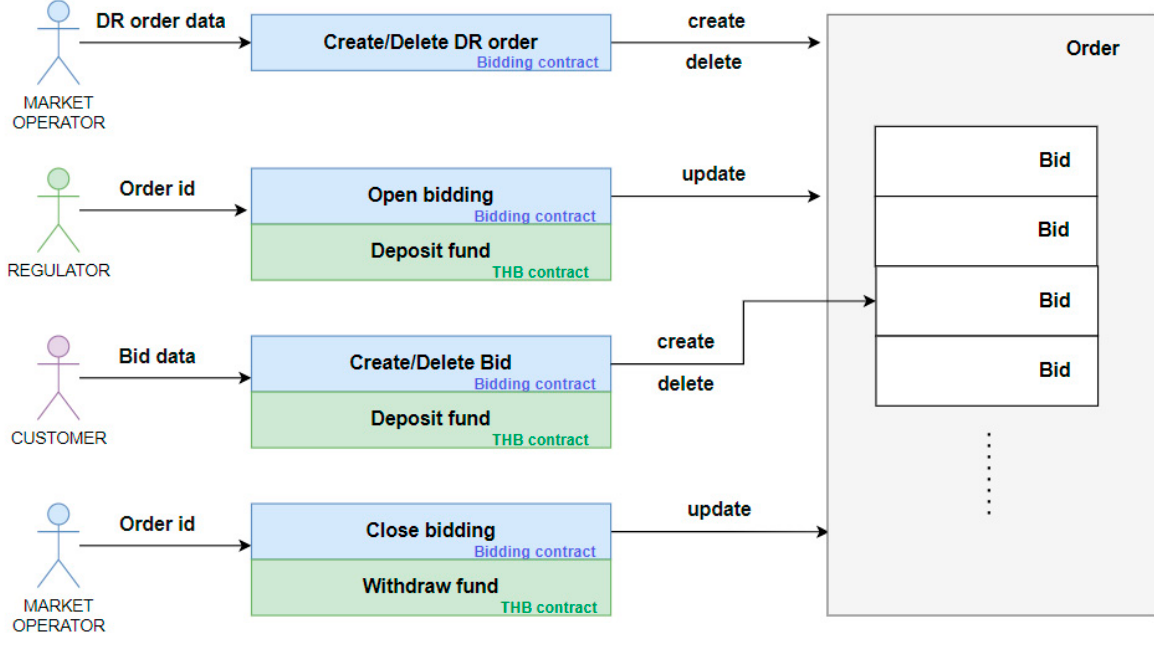
Figure 4. Bidding system.